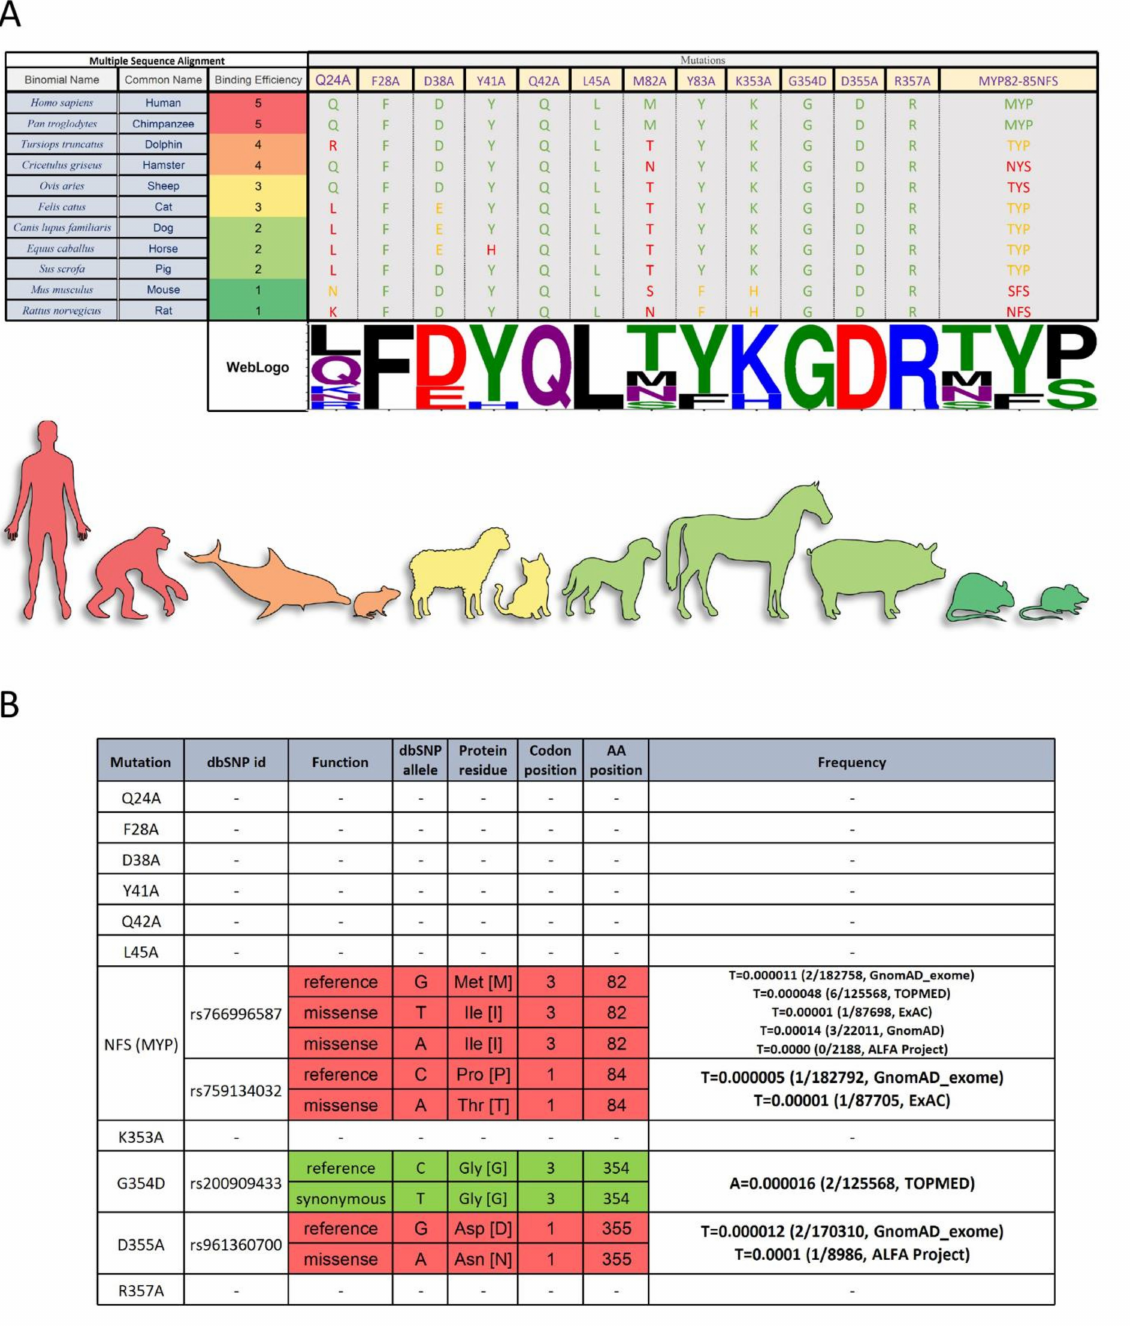
Figure 5. Multiple Sequence Alignment Analysis and single nucleotide polymorphisms (SNP) Frequency Analysis of ACE2 Mutants. ( A ) Sequences were reordered based on their binding efficiency to RBD. Only the target mutation sites are shown, and the non-target amino acids (AA) has been cut out from the alignment representation. The alignment coloring scheme is based on the chemical properties of each AA (each Human AA is green, the AA from the same chemistry is orange, and AA with different chemistry is red. Except for the last column with three AAs which the number of identical AAs to the human determines the color. WebLogo (http://weblogo.threeplusone.com (accessed on 1 February 2021)) representation shows a relative scale of the presence of each AA in each column. ( B ) dbSNP data on single nucleotide Polymorphism in the ACE2 nucleotide sequence on the target amino acid codons. The frequency of each SNP in different datasets was gathered in the last column. A synonymous mutation (no effect on the protein sequence) is green and missense mutations are